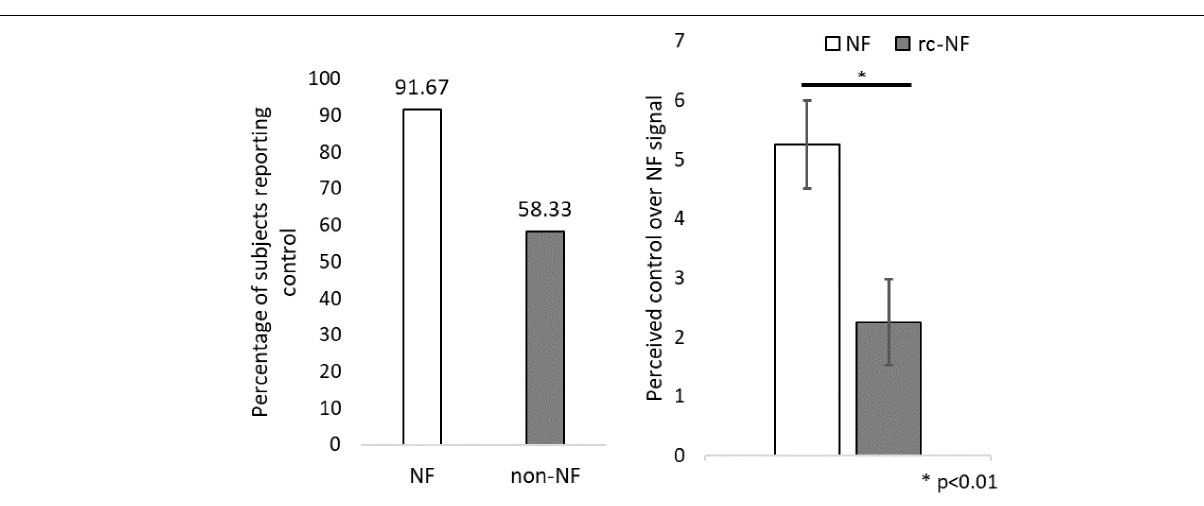
Frontiers in Neuroscience |